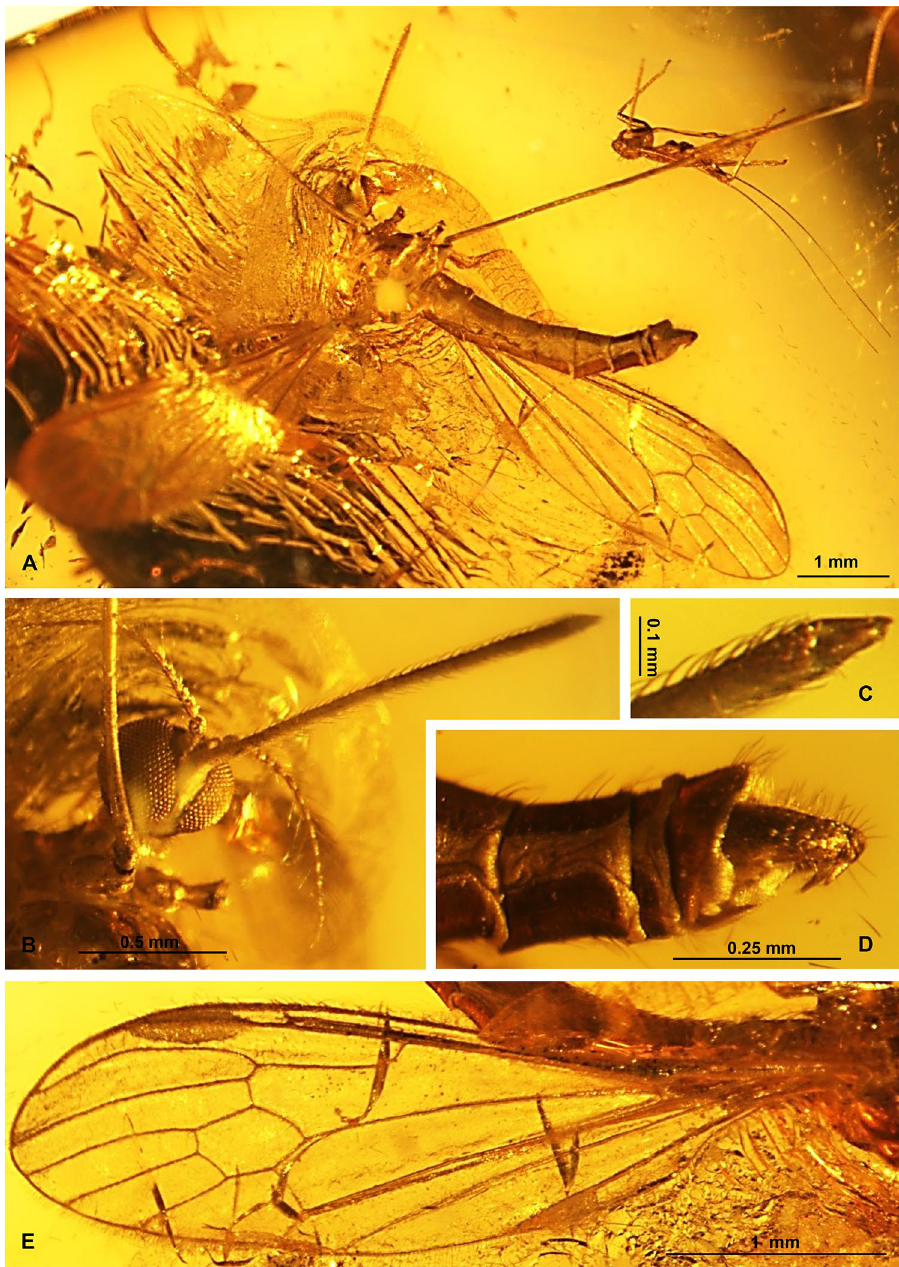
Figure 6. Elephantomyia ( Hoffeinsonia ) prima sp. nov. No. CCHH 874–1 (male), coll. Ch. & H. W. Hoffeins, holotype, photographs: ( A ) body, latero-dorsal view; ( B ) head, latero-ventral view; ( C ) apical part of rostrum with palpi visible; ( D ) hypopygium, lateral view; ( E )